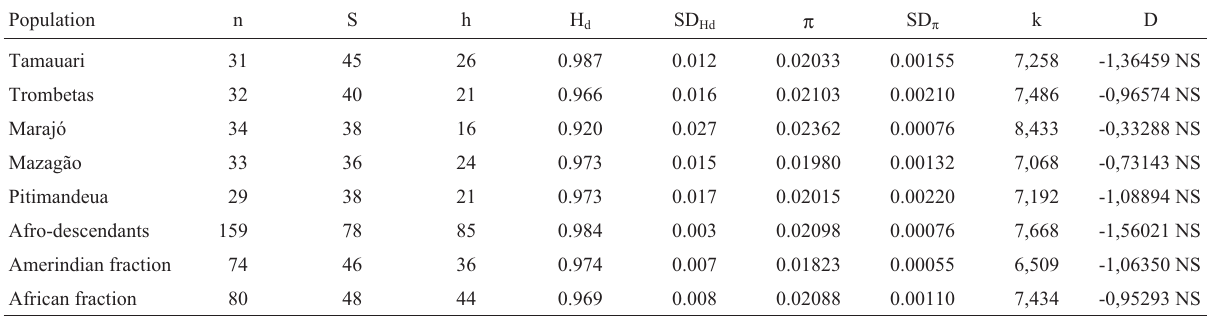
Table 2 - Genetic diversity in Afro-descendant populations from the Brazilian Amazon. The Table shows number of samples (n), number of variable nu- cleotides (S), number of haplotypes (h), genetic diversity (H d ), standard deviation of the genetic diversity (SD Hd ); nucleotide diversity ( π ),standard devia- tion of the nucleotide diversity SD π , average pairwise differences (k) and Tajima test value (D). NS = not significant. Population